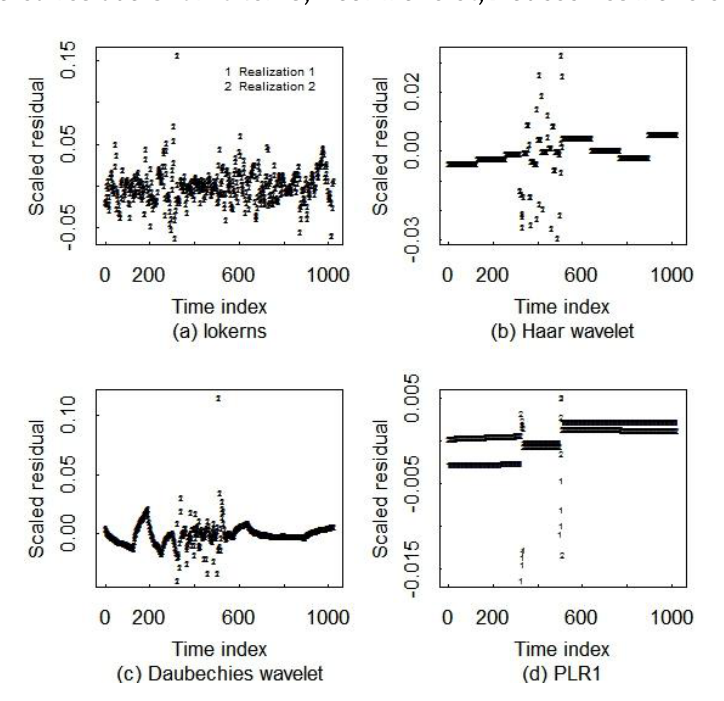
Figure 5. Scaled residuals for lokerns, Haar wavelet, Daucechies wavelet, and